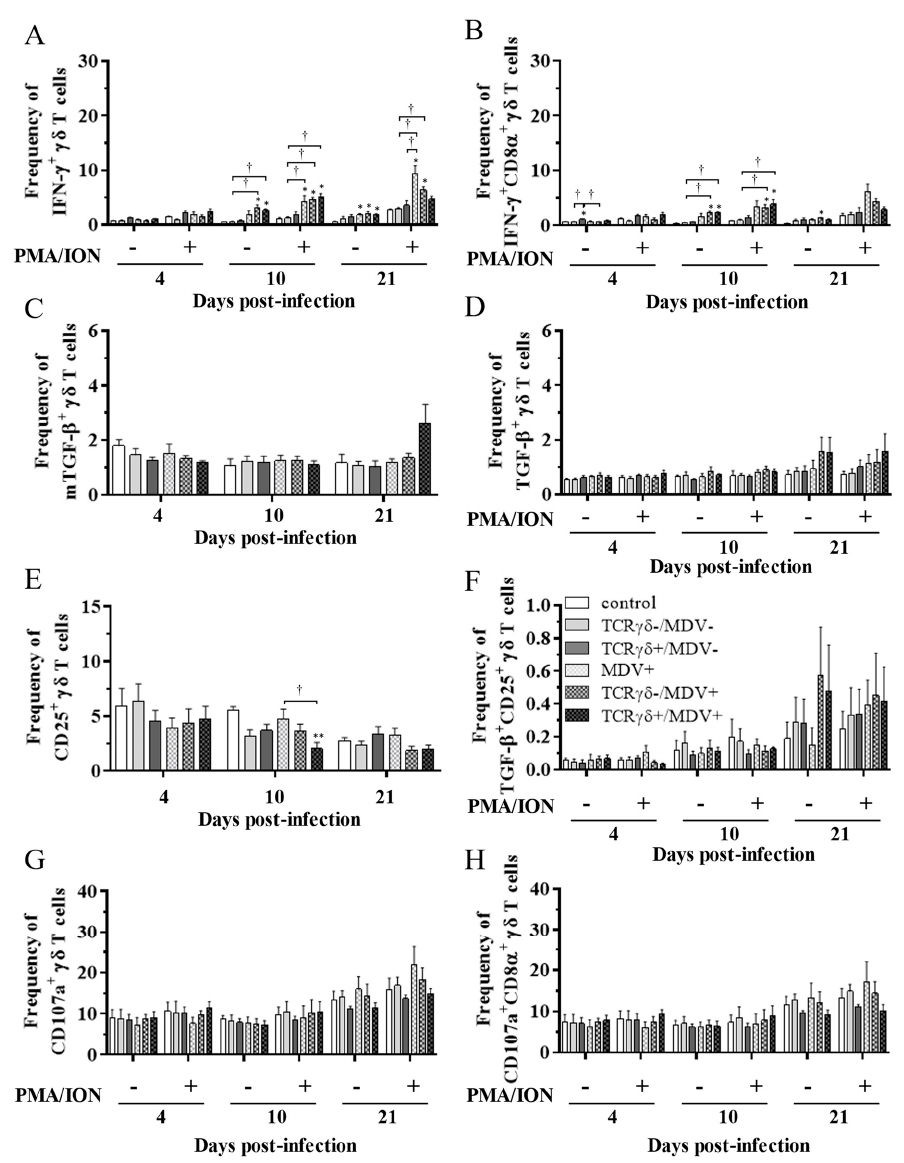
Figure 7. Cytokine and immune system molecule profiles in γδ T cells derived from the spleen at 4, 10, and 21 dpi. Mononuclear cells isolated from the spleen of the control, the TCR γδ‐ /MDV ‐ , the TCR γδ +/MDV ‐ , the MDV+, the TCR γδ‐ /MDV+, and the TCR γδ +/MDV+ groups were cultured with and without PMA/ION for 4 h. Percentages of IFN ‐γ + γδ T cells ( A ), IFN ‐γ + CD8 α + γδ T cells ( B ), mTGF ‐β γδ T cells ( C ), TGF ‐β γδ T cells ( D ), CD25 + γδ T cells ( E ), TGF ‐β + CD25 + γδ T cells ( F ), CD107a + γδ T cells ( G ), and CD107a + CD8 α + γδ T cells ( H ) within γδ T cell populations in the spleen collected from each group at 4, 10, and 21 dpi are shown. Data represent the mean of 5 biological replicates ± SE in each group at each time point. Significant differences are indicated by *: p < 0.05 (vs. control) and †: p < 0.05.